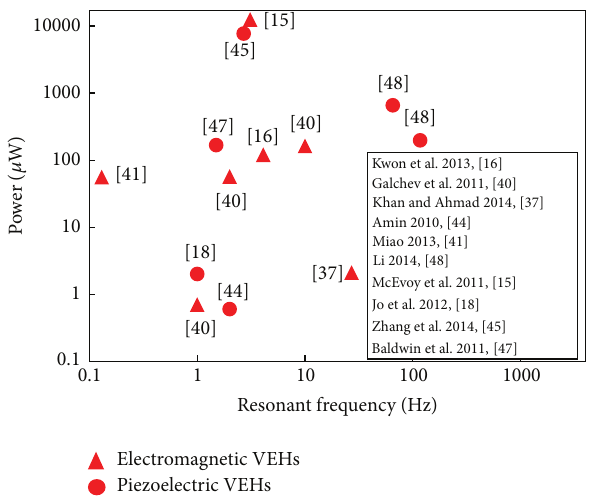
Figure 23: Power developed by the bridge vibration energy har- vesters as function of harvester’s resonant